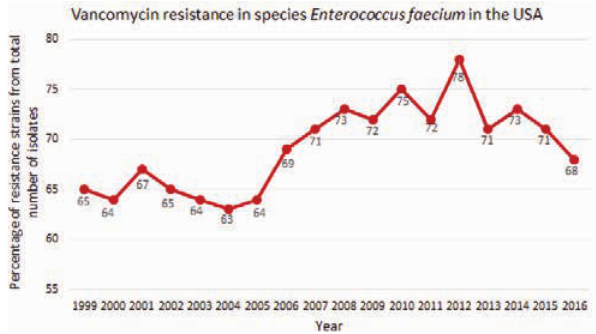
Figure 6: Graph of percentage of resistant strains of species